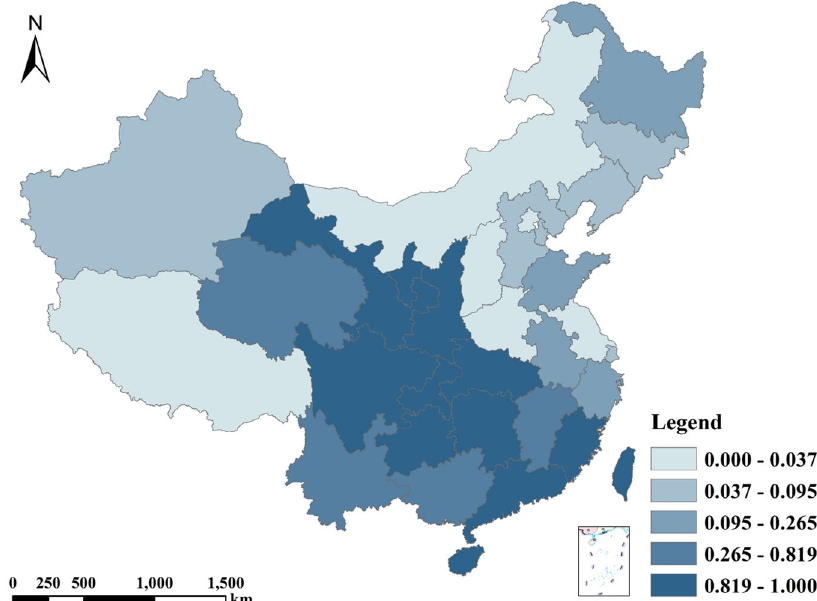
Fig. 1 Probability distribution of the non-carcinogenic health risk (NCR) exceeding the risk threshold ( P NCR ). [Note: Regardless of the type of heavy metal(loid), the highest P NCR in each province was taken to indicate the highest possible NCR. The shade of blue indicated the probability of non- carcinogenic risk exceeding the standard. The darker the blue, the higher the probability].